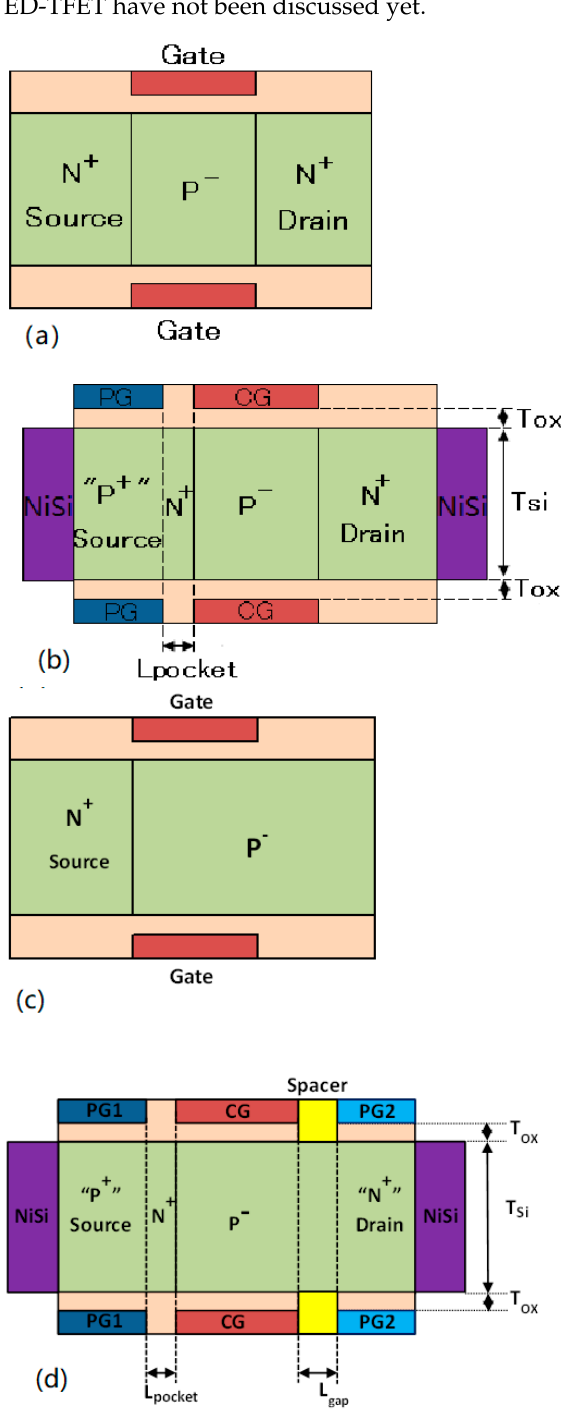
Figure 1. Cross-sectional views of ( a ) initial NPN structure used to realize conventional in-built N + pocket ED-TFET, ( b ) conventional in-built N + pocket ED-TFET, ( c ) initial NP structure used to realize in-built N + pocket ED-TFET with an ED drain, and ( d ) in-built N + pocket ED-TFET with an ED drain.